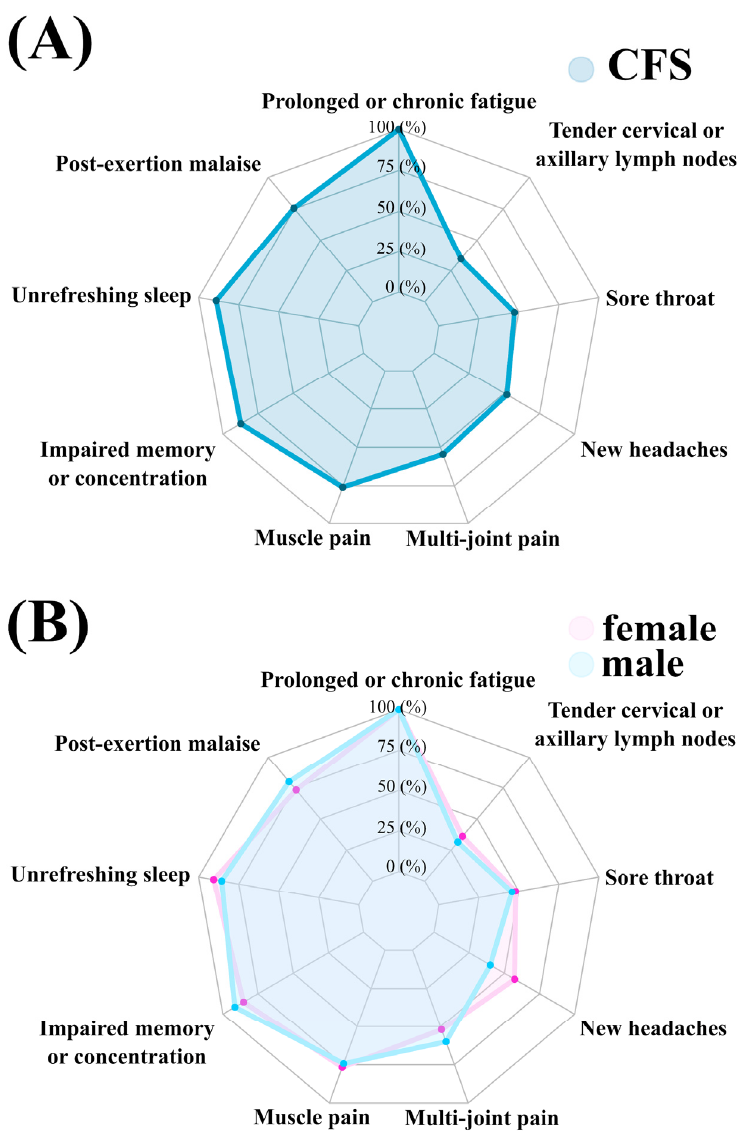
Figure 1. Spider chart on the prevalence of Fukuda symptoms in the whole sample ( A ) and in females and males ( B ).